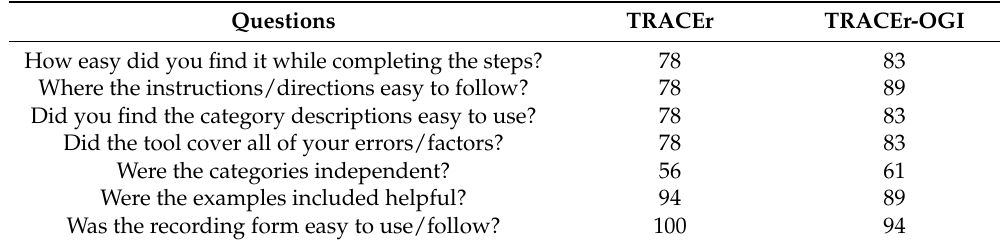
Table 11. Participants rating of ease of